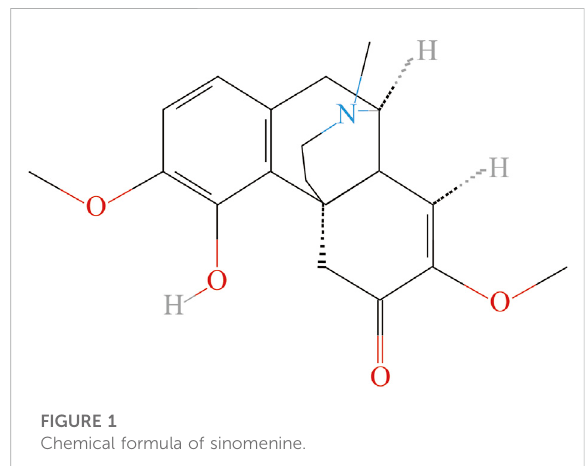
FIGURE 1 Chemical formula of